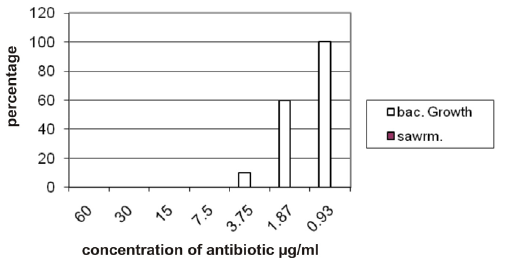
Fig. 1. Effect of Imipenem on growth and swarming of Proteus